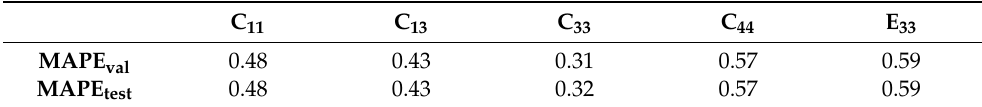
Table 2. Average evaluation of the results in the parameter